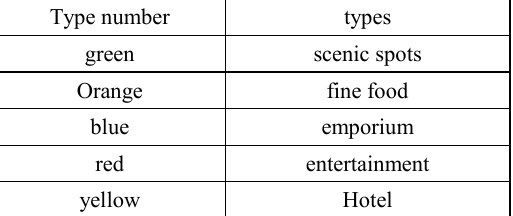
Table 1. Attractions Type Table Structure